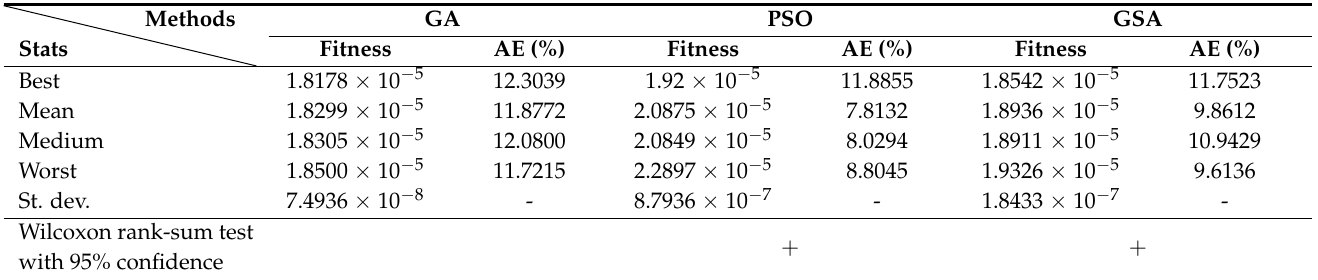
Table 4. Statistical values of the SPTECPs using the optimization methods for the single-phase transformer 15 kVA, 2400–240 V at 50 Hz.